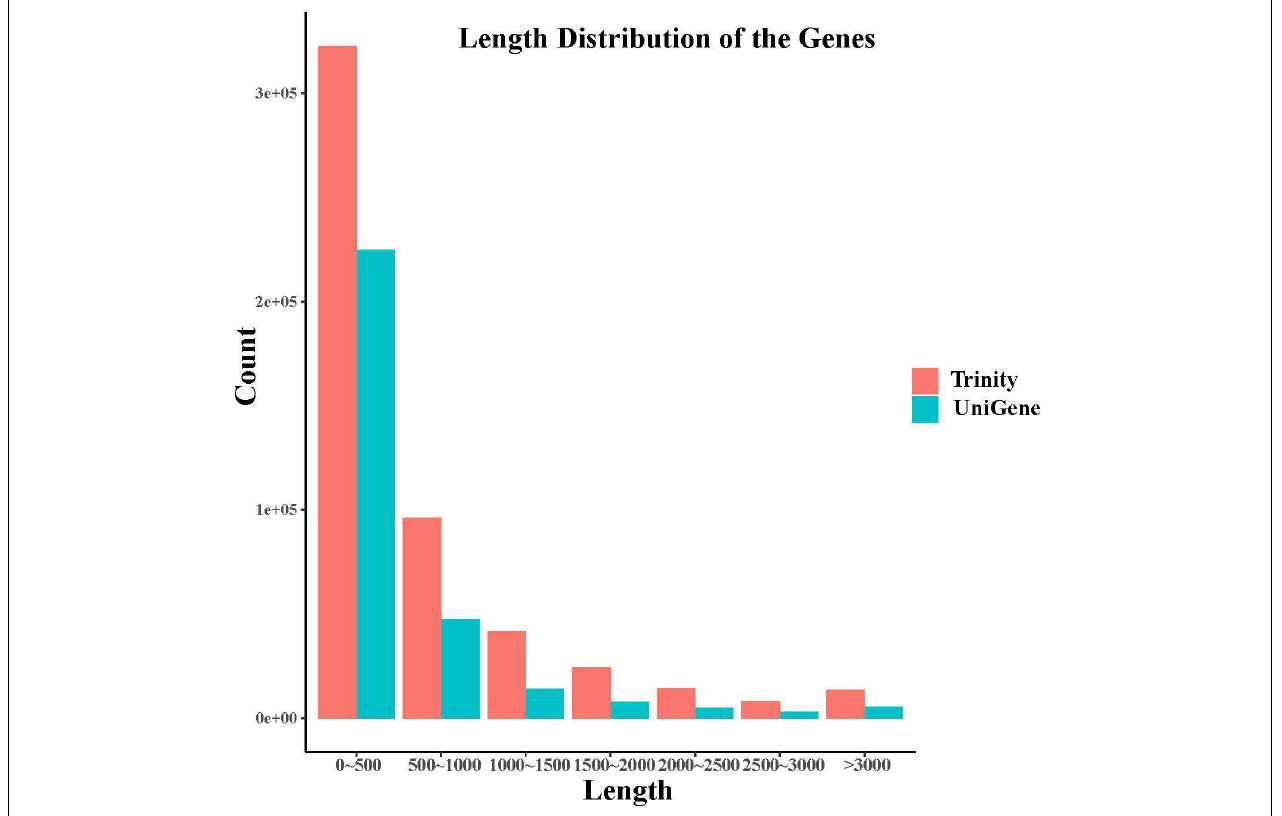
FIGURE 1 | Length distribution of contigs and unigenes derived from S. caldwelli .